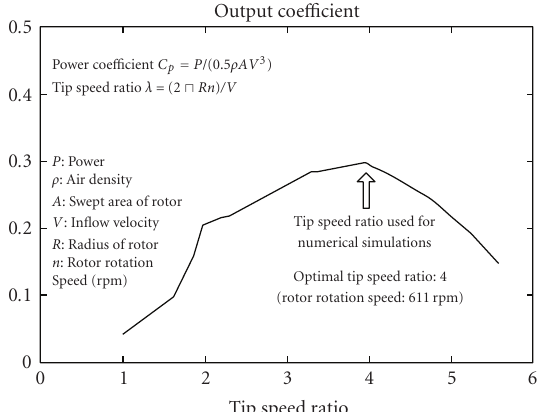
Figure 2: Relationship between the tip speed ratio and the power coe ffi cient of the wind turbine generator (WTG) tested in the wind- tunnel